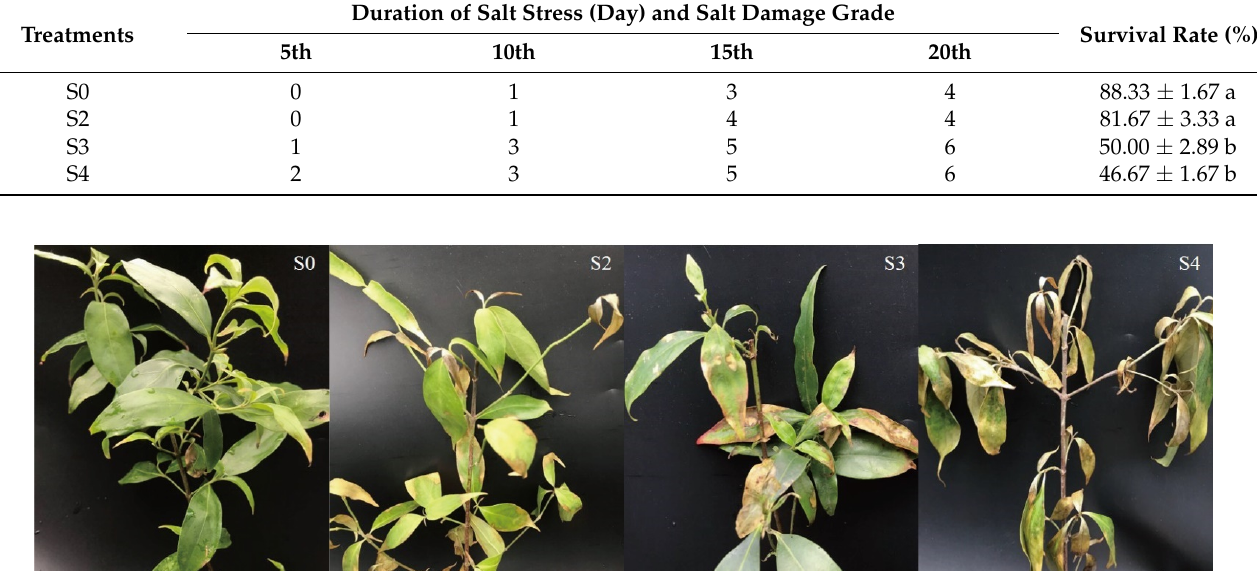
Table 3. Salt damage levels of Cornus hongkongensis subsp. elegans (W. P. Fang et Y. T. Hsieh) Q. Y. Xiang seedlings at various stages of salt stress. S0, S2, S3, and S4 indicate control, 0.2%, 0.3%, and 0.4% salt concentration treatments, respectively. Values are the mean ± standard error. Values for each column followed by different letters denote a significant difference among different treatments according to Duncan’s new multiple range test ( p < 0.05). Treatments